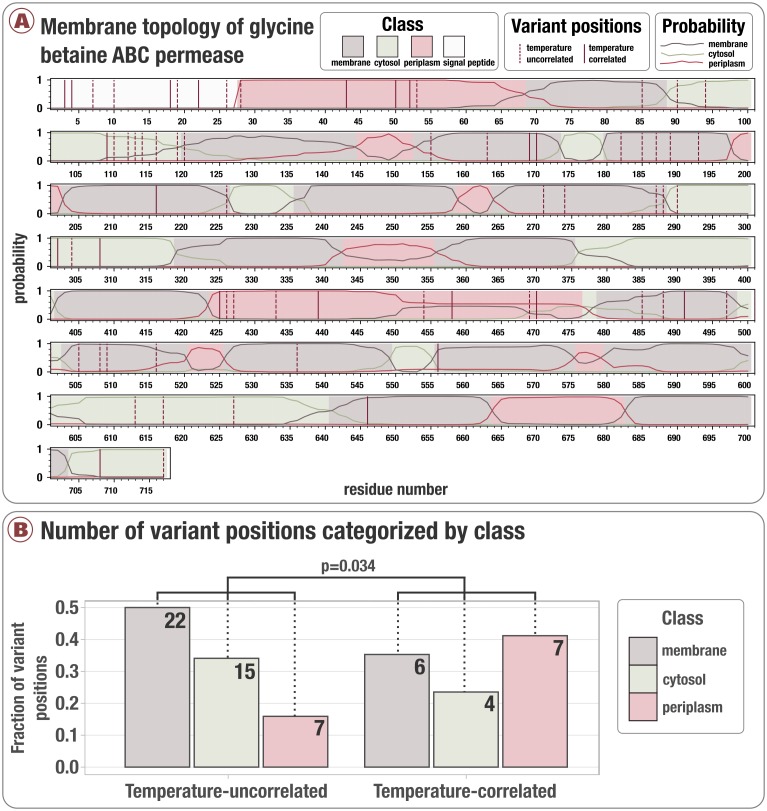
Analysis of how temperature-correlated variant positions distribute within Gene 1727, a glycine betaine ATP-binding cassette permease subunit identified for its rare proportion of temperature-correlated variant positions.Panel A illustrates the membrane topology predicted by Phobius (See Materials and methods), which associates to each position a probability it is periplasmic, cytosolic, transmembrane, or within the signaling peptide (colored lines). We categorized each position according to the maximum probability (shaded regions). Temperature-correlated and uncorrelated variant positions are denoted by solid red and dashed red vertical lines, respectively. Panel B illustrates the frequency that variant positions are found in the membrane, cytosol, and periplasm, based on whether or not they correlate with temperature. The y-axis is the fraction of variant positions observed (excluding positions observed in the signaling peptide), and numbers within each bar denote the number of variant positions observed within each class. The probability that positions are distributed independent of temperature correlation was 0.034. Formally, this is the probability that temperature-correlated positions were distributed according to a trinomial distribution with a probability vector equal to the empirical distribution observed in temperature-uncorrelated positions.